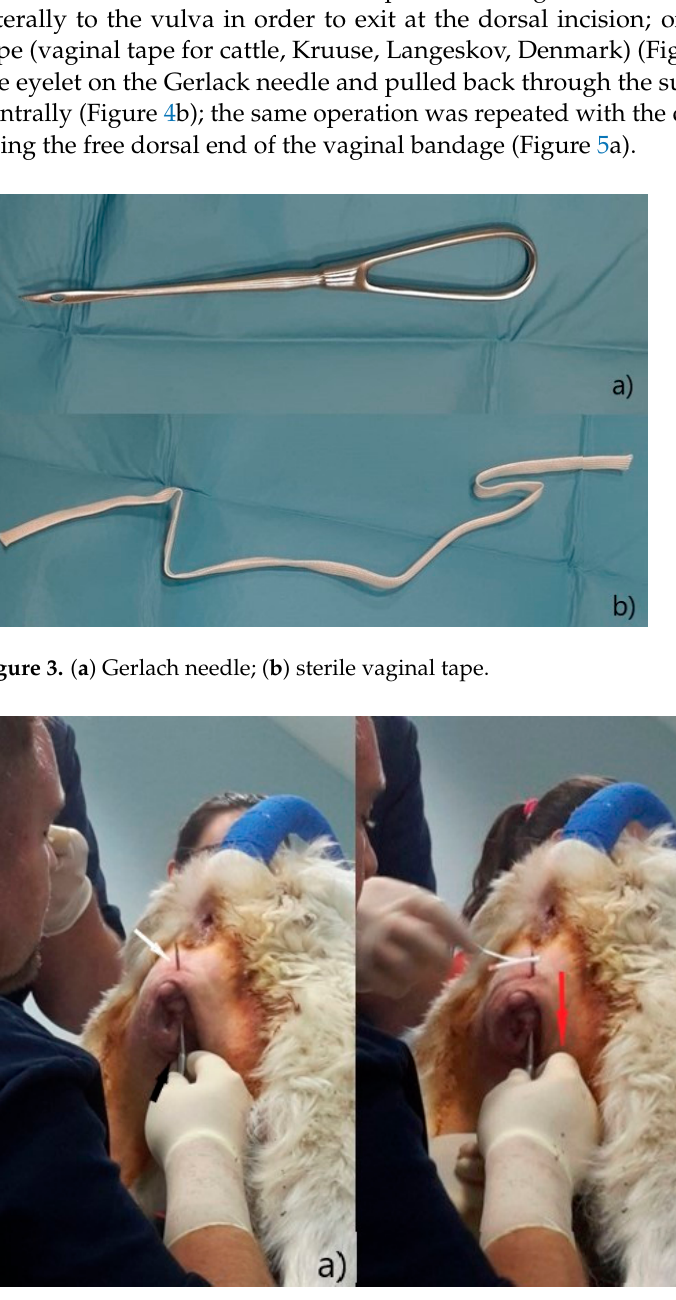
Figure 4 . Bühner technique: ( a ) place the Gerlach needle into the ventral incision (black arrow) and push it through the subcutaneous tissue, laterally to the vulva, exiting at the dorsal incision (white arrow); ( b ) thread one end of the tape into the eyelet of the needle and pull it back, through the subcutaneous tissue (red arrow).